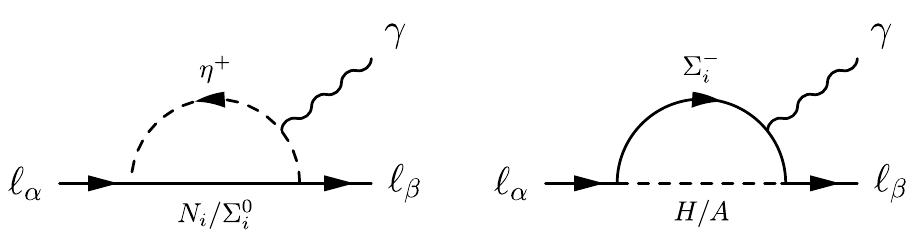
Figure 1 . Feynman diagrams for the charged lepton flavor violation process ‘ α → ‘ β γ . The diagrams that a photon is attached to the external legs do not contribute to the amplitude and are